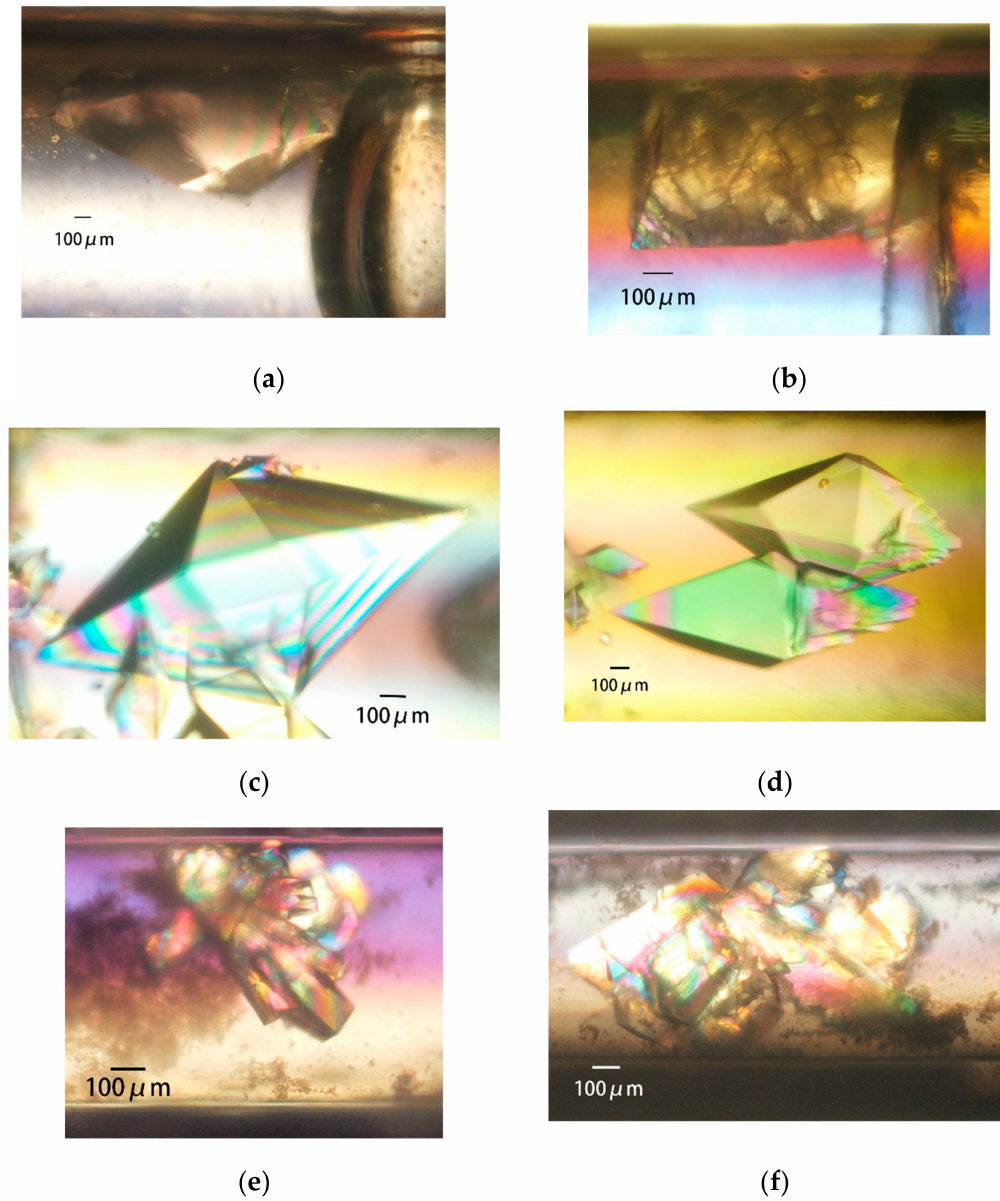
Figure 9. Space- and ground-grown crystals. PcCel6A crystals grown in space ( a ) and terrestrially ( b ) by the counter-di ff usion (CD) method; 39.3 mg / mL PcCel6A, 90 mM sodium chloride, and 10 mM cellotriose in 5 mM Tris-HCl pH 7.5 are loaded in a 2 mm bore capillary. After the Gel-Tube is plugged [31], the capillary is placed in a reservoir solution containing 46.4% PEG 4000, 5 mM cellotriose, and 50 mM sodium acetate pH 4.5. Thaumatin crystals grown in space ( c ) and terrestrially ( d ) by the dialysis (DL) method; 33.7 mg / mL thaumatin in 50 mM HEPES pH 7.0 is loaded in a 2 mm bore capillary with a dialysis membrane [31]. The capillary is placed in a reservoir solution containing 25% PEG 4000, 100 mM sodium chloride, 75 mM sodium tartrate, and 50 mM HEPES pH 7.0. H-Protein crystals grown in space ( e ) and terrestrially ( f ) by the CD method; 38.2 mg / mL H-protein, 25 mM sodium chloride, 500 mM ammonium sulfite, 20 mM sodium citrate pH 3.0, 0.4 mM DTT, and 4% glycerol are loaded in a 0.7 mm bore capillary. After the Gel-Tube is plugged [31], the capillary is placed in a reservoir solution containing 2.5 M ammonium sulfate, 25 mM sodium chloride, and 100 mM sodium citrate pH